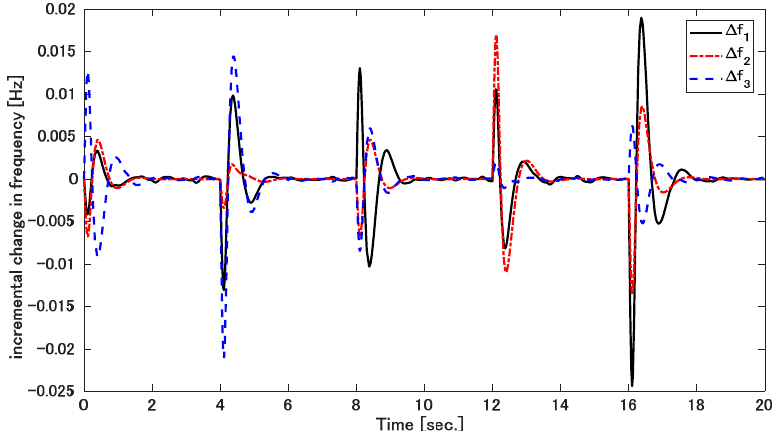
Figure 21. Frequency deviation with wind plant.